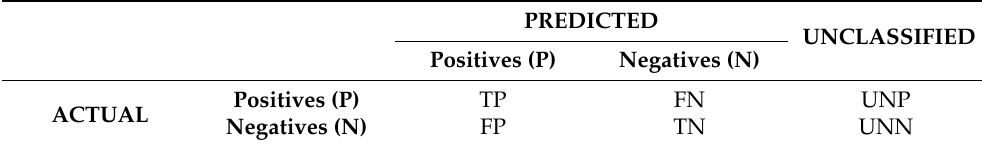
Table 4. Confusion